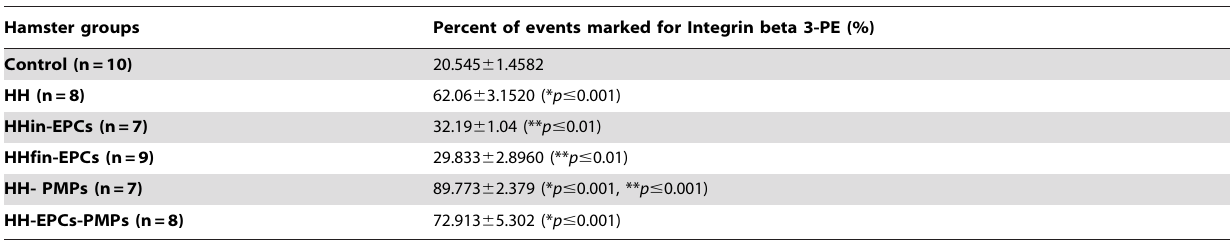
Hamster groups Percent of events marked for Integrin beta 3-PE